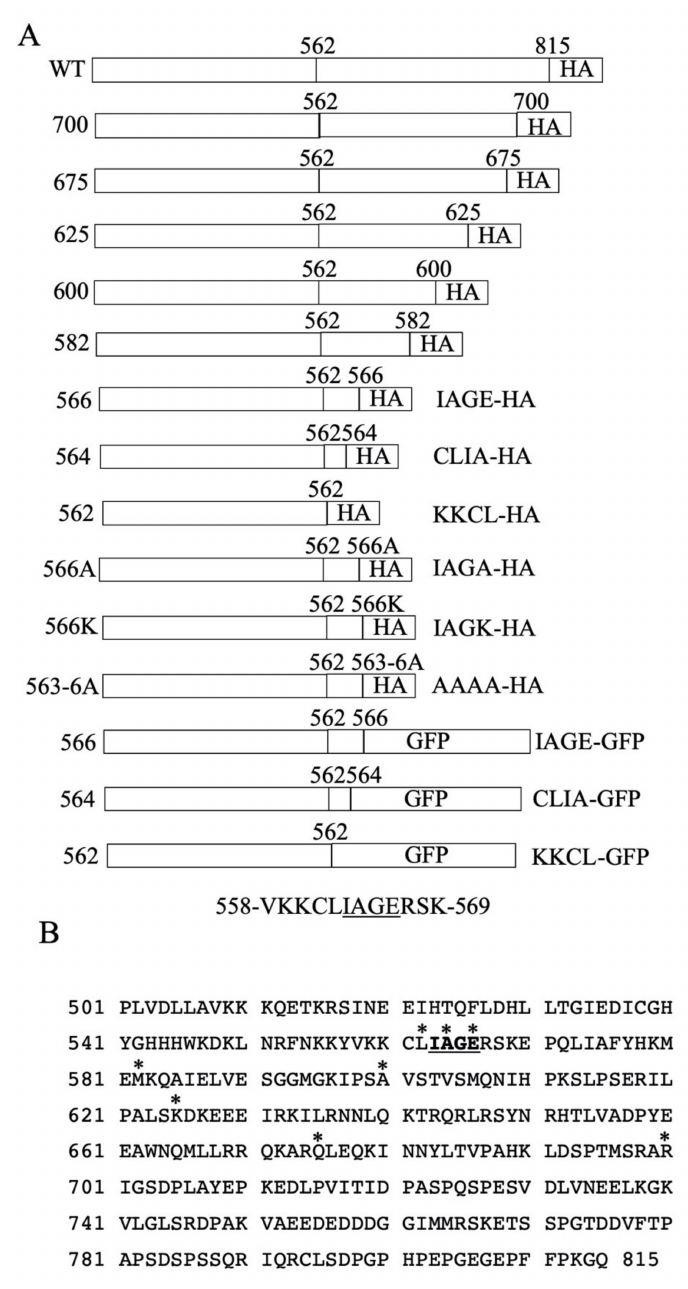
Figure 1. Na + / H + exchanger (NHE1) sequence and constructs. ( A ) Schematic diagram of NHE1 constructs shortened at the carboxyl terminal region. All proteins were expressed from the initiator methionine of NHE1. Wild type (WT), full length NHE1 with an HA (hemagglutinin) tag. The number of the last amino acid of the C-terminus of NHE1 is indicated. For shorter constructs, the last four amino acids prior to the HA (or GFP) tag are shown. GFP indicates a green fluorescent protein tag. The sequence of amino acids 558–569 of NHE1 is shown below. ( B ) Amino acid sequence of the human NHE1 cytosolic regulatory domain, amino acids 501–815. Amino acids 563–566 are underlined and bold. * above an amino acid indicates the position where the protein’s C-terminal was terminated in order to form that amino